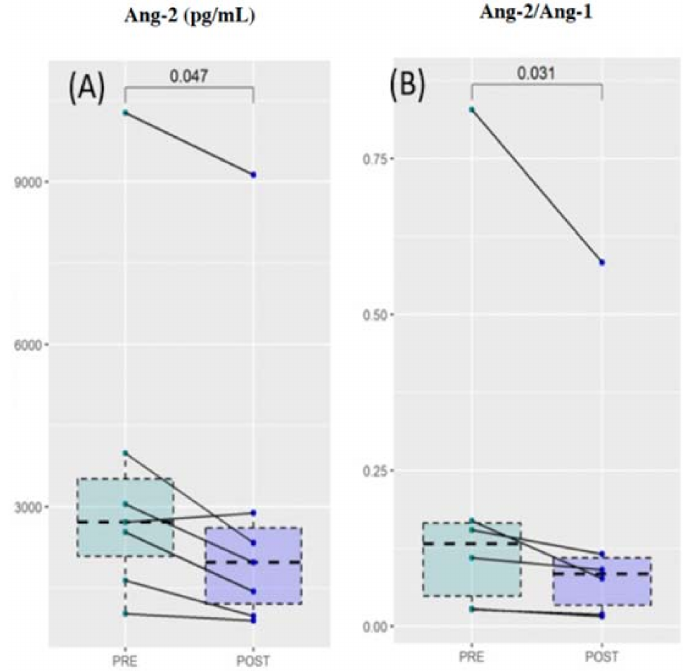
Figure 2. Comparative analysis of Ang-2 levels ( A ) and the Ang-2/Ang-1 ratio ( B ) before and after the treatment of patients diagnosed with viral hepatitis with the required antiviral